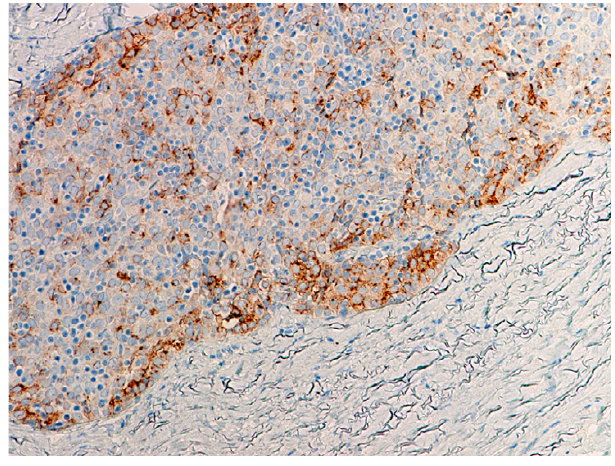
Figure 8 (B-SA, anti-CD57, × 200):Type B3 thymoma associated with myasthenia gravis. Strong expression of CD57 in the majority of neoplastic